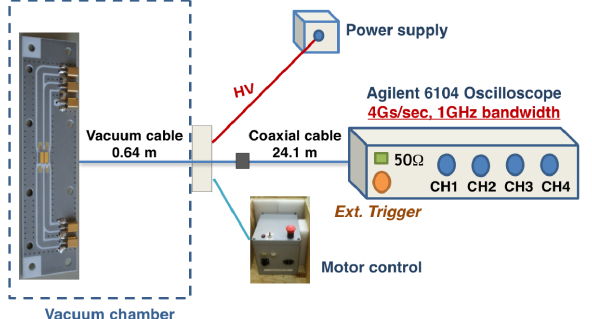
FIG. 6. Layout of diamond sensor on ceramic PCB (left) and the data acquisition system (right).